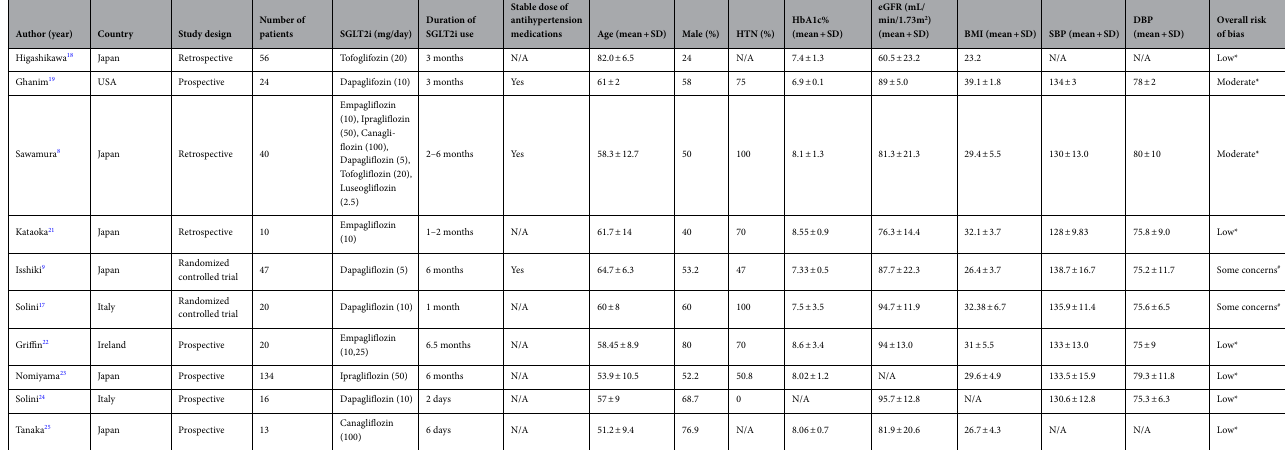
Table 1. Characteristics of included studies. N/A Data not available, HTN Hypertension, BMI Body mass index, SBP Systolic blood pressure, DBP Diastolic blood pressure. *Assessed by ROBINS-I tool. # Assessed by RoB